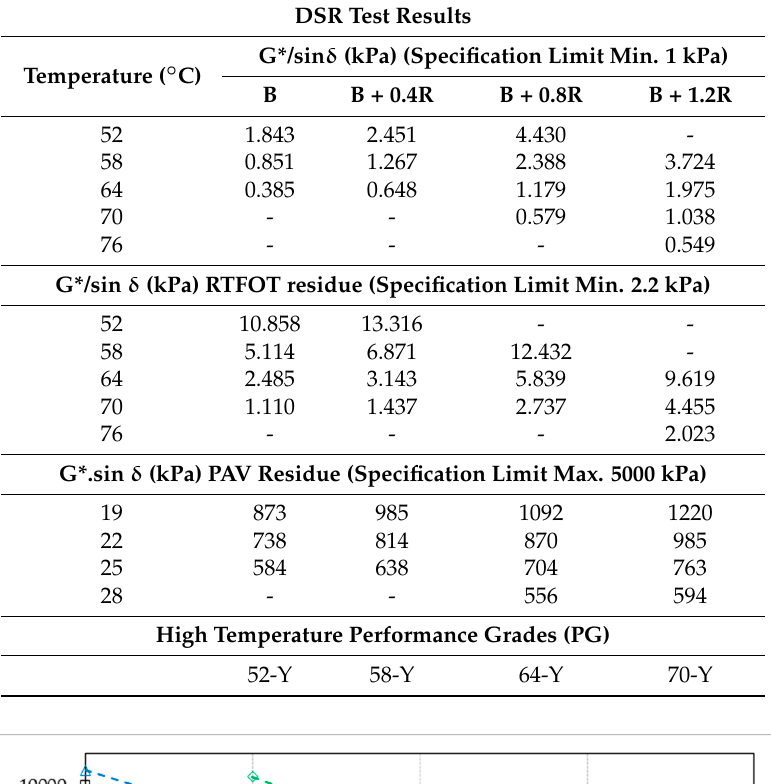
Table 6. The DSR test results of all binders. DSR Test Results